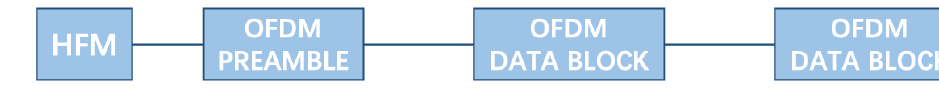
Figure 3. OFDM data frame structure.